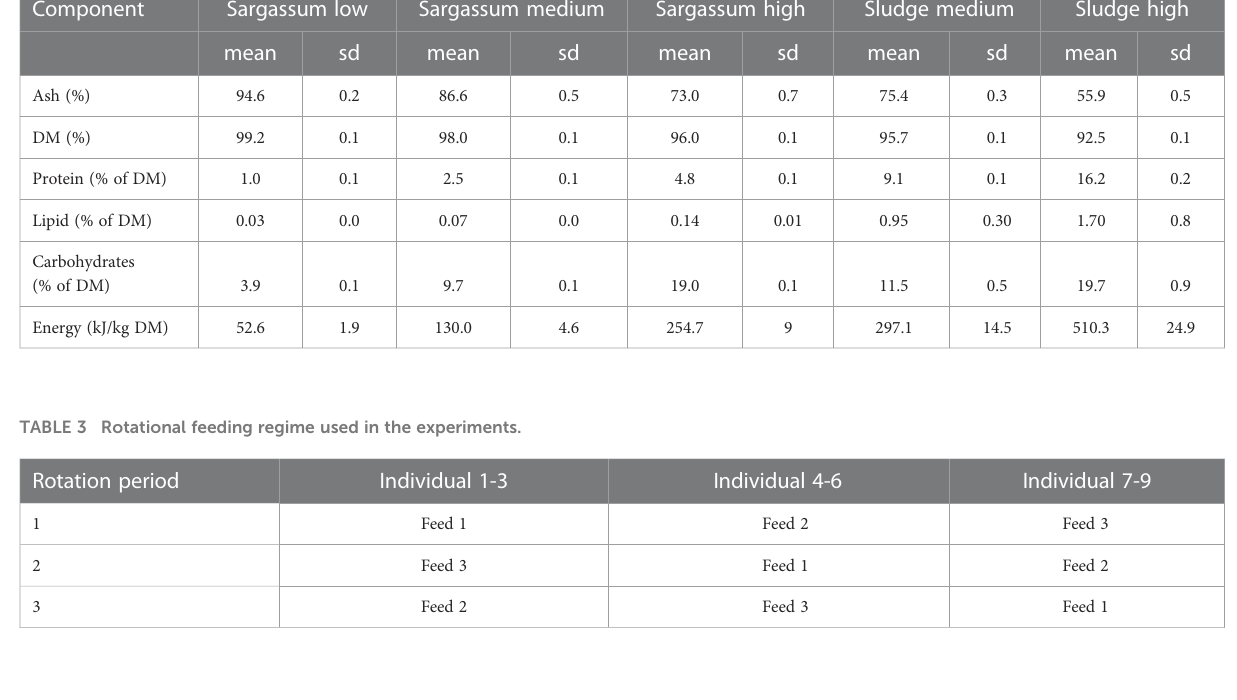
TABLE 2 Ash, dry matter (DM), macronutrient composition and energy content of the experimental feeds (n=3, sd=standard deviation) used in Experiment 1 and Experiment 2. Component